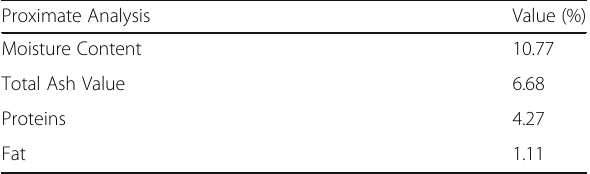
Table 1 Proximate composition of dried L. sativus L. seeds Proximate Analysis